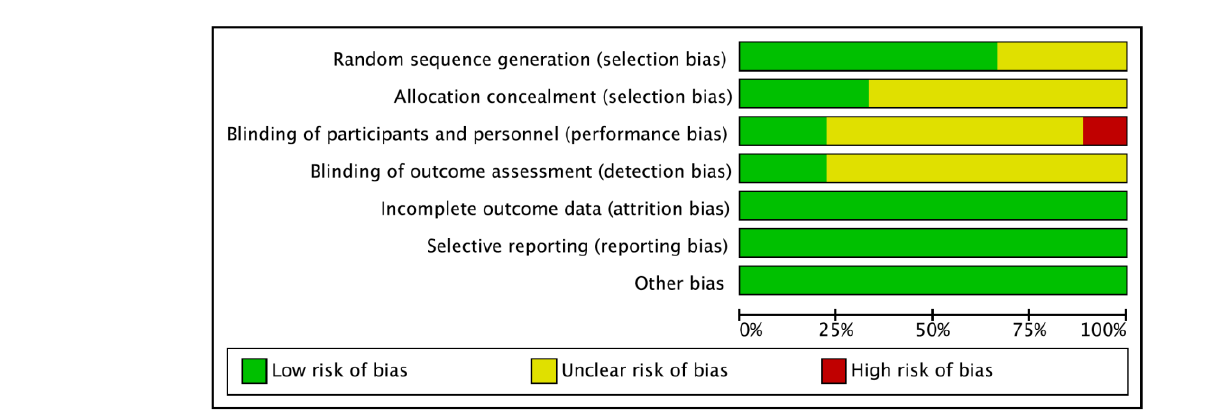
Figure 2. Risk of bias in studies .